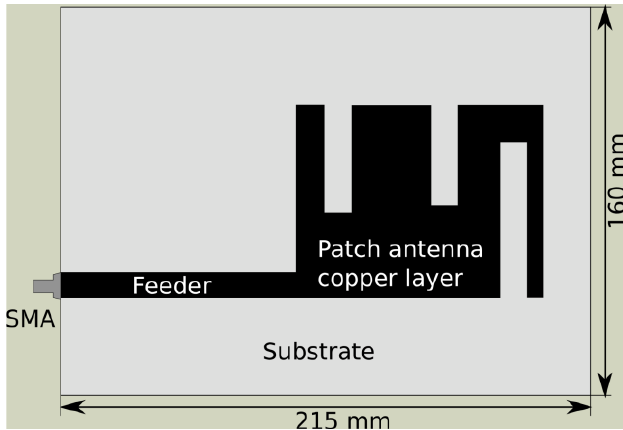
Figure 13. Shape of copper plane in sample rectenna; redrawn from [64].